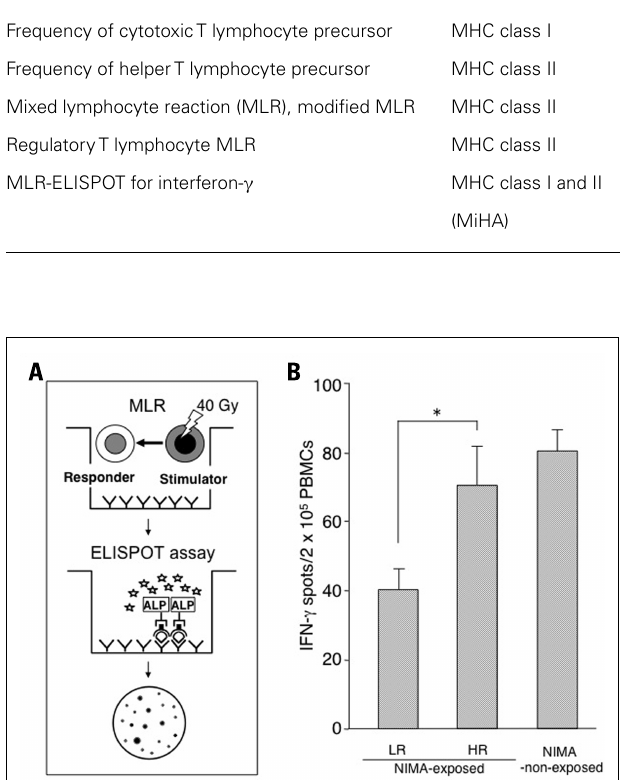
FIGURE 3 | Prediction of the reactivity to NIMA by the MLR-ELISPOT assay. (A) The ELISPOT assay combined with MLR (MLR-ELISPOT) is a sensitive functional assay to detect alloreactivity for both major and minor histocompatibility antigens in mice. (B) The mice were classified into two groups based on their reactivity to NIMA; the high responders (HR ≥ mean ± 1 SD in NIMA-non-exposed) or the low responders (LR < mean ± 1 SD) group by using MLR (Araki etal., 2010).The IFN- γ -producing ability before the induction of GVHD was presented by the MLR-ELISPOT assay. Peripheral blood mononuclear cells from NIMA-exposed LR mice ( n = 8), NIMA-exposed HR mice ( n = 7), and non-exposed mice ( n = 6) were stimulated with B10 mouse peripheral blood mononuclear cells.The data are expressed as the means ± SD of individual animals. * p <